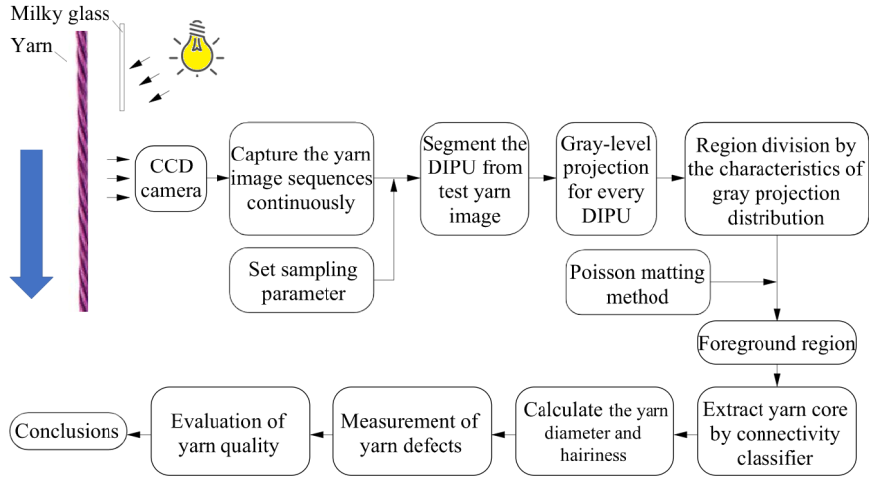
Figure 1. Flowchart of the method for detecting yarn parameters and evaluating yarn quality (Adapted from [6]).